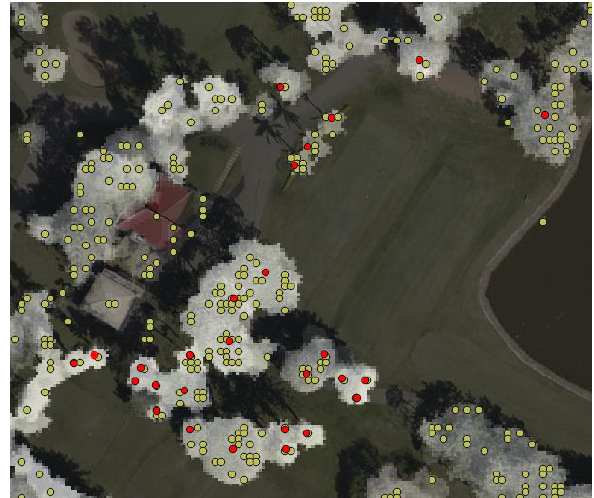
Figure 5. Extraction result of the VWF method using the pit-free CHMs